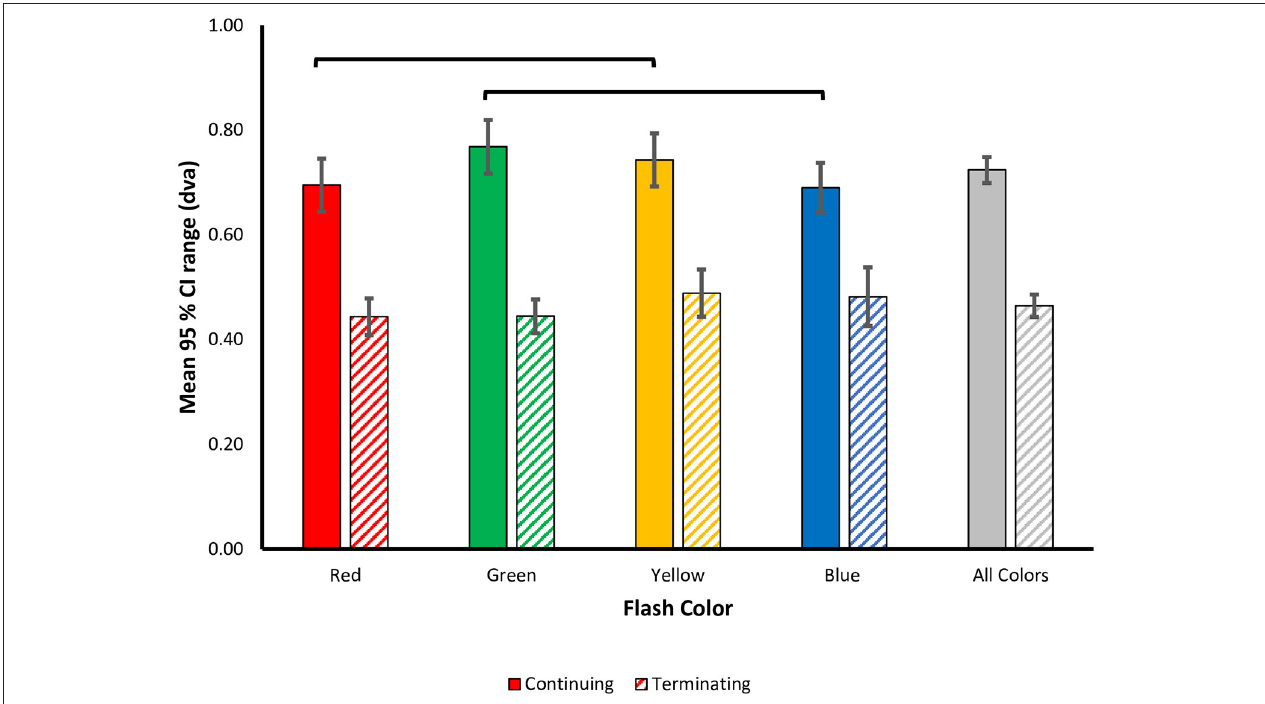
FIGURE 5 | Color modulation of response variability in the flash jump illusion. Precision in responses was measured as the mean 95% CI range ± SEM and plotted as a function of flash color for each motion path. Lines represent color differences unadjusted for multiple